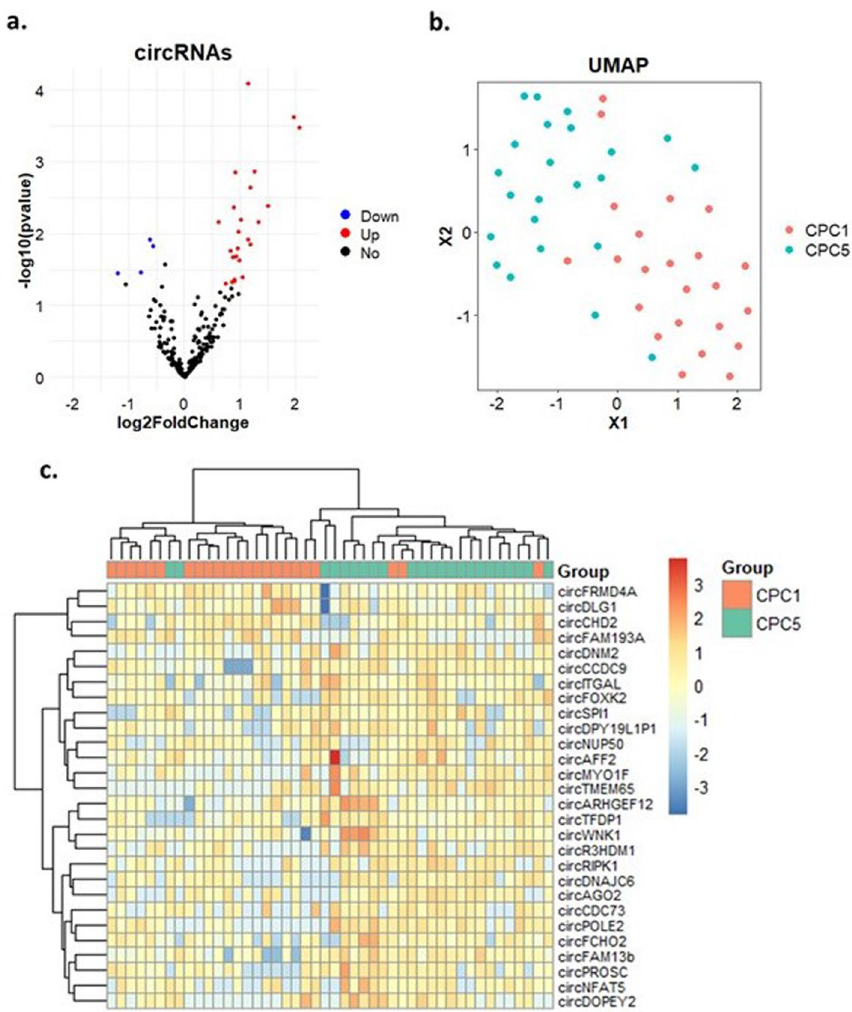
Fig. 1 RNA‑seq results from the discovery study in 46 TTM‑trial patients. a Volcano plot showing the differential expression of the circRNAs in the CPC5 group as magnitude of change (log2‑fold change) on the X‑axis versus statistical significance (‑log10) on the Y‑axis. Color code: red, circRNAs significantly upregulated in the CPC5 group; blue, circRNAs significantly downregulated in the CPC5 group; black, circRNAs with no significant change. b UMAP analysis showing the clustering of the patients with X1 and X2 representing the distance between samples. Color code: red, patients with CPC1; blue, patients with CPC5. c Heatmap representing the expression levels of 28 circRNAs in each of the 46 RNA‑seq samples. Color code: red, higher expression; blue, lower